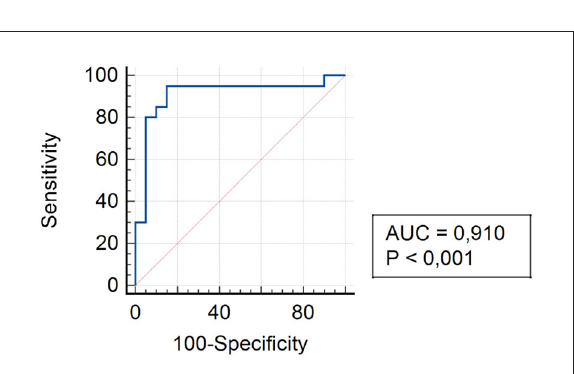
FIGURE6 ROC curve for TLR4 expression in patients of Group III 3 and 6 months after